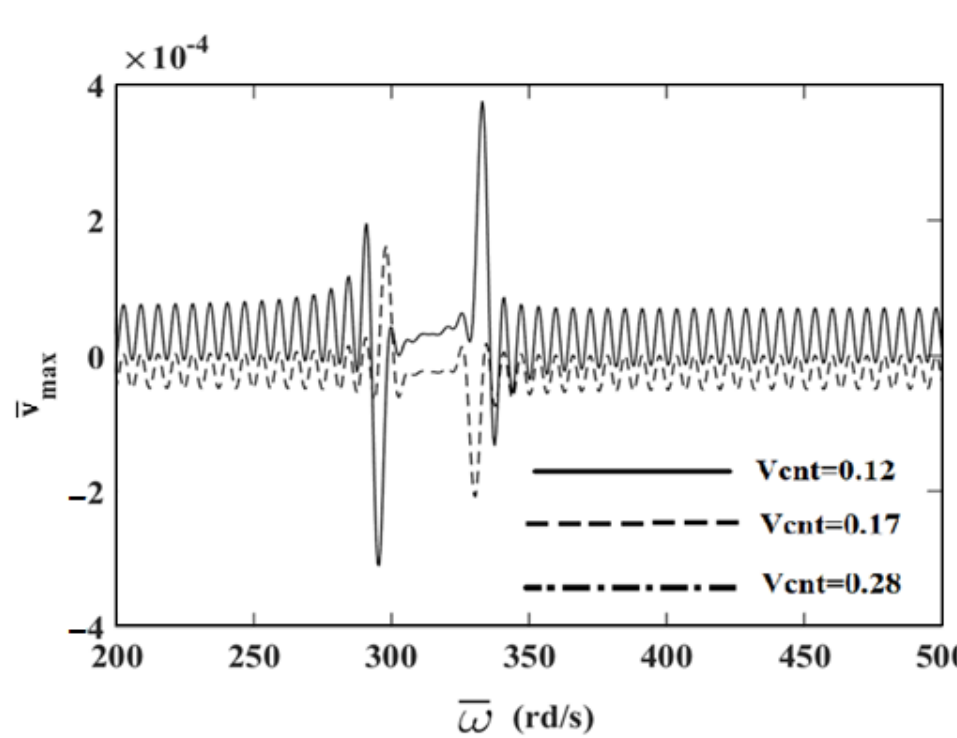
Figure 10. The relationship between of the displacements and the frequency of the dynamic load ( 𝑤̅ ) in the simply supported X-Beam for different values of V CNT .